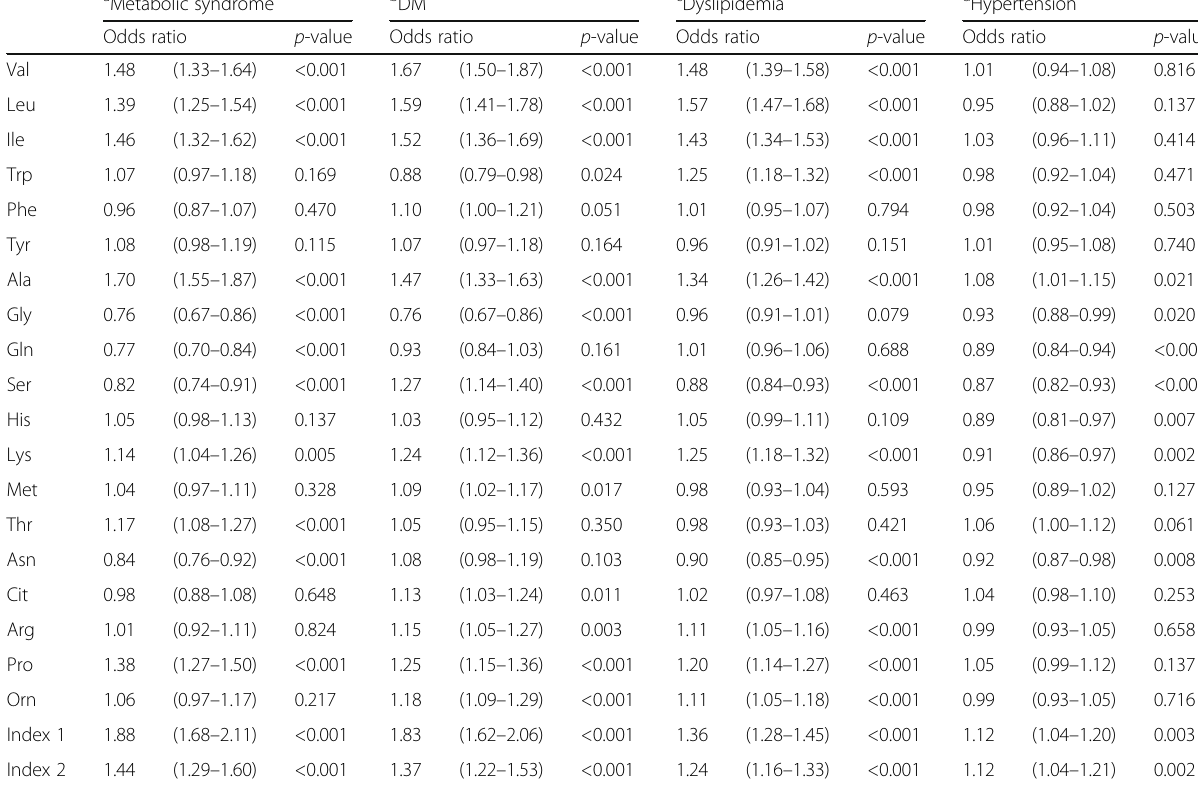
Values are odds ratios (95% confidence intervals) as a continuous variable per SD increment for developing metabolic syndrome, DM, dyslipidemia, or hypertension from logistic regressions a Adjusted for age, gender and BMI b Adjusted for age, gender, BMI, LDL-C, HDL-C, TG, SBP and DBP c Adjusted for age, gender, BMI, FPG, HbA1c, SBP and DBP d Adjusted for age, gender, BMI, FPG, HbA1c, LDL-C, HDL-C and